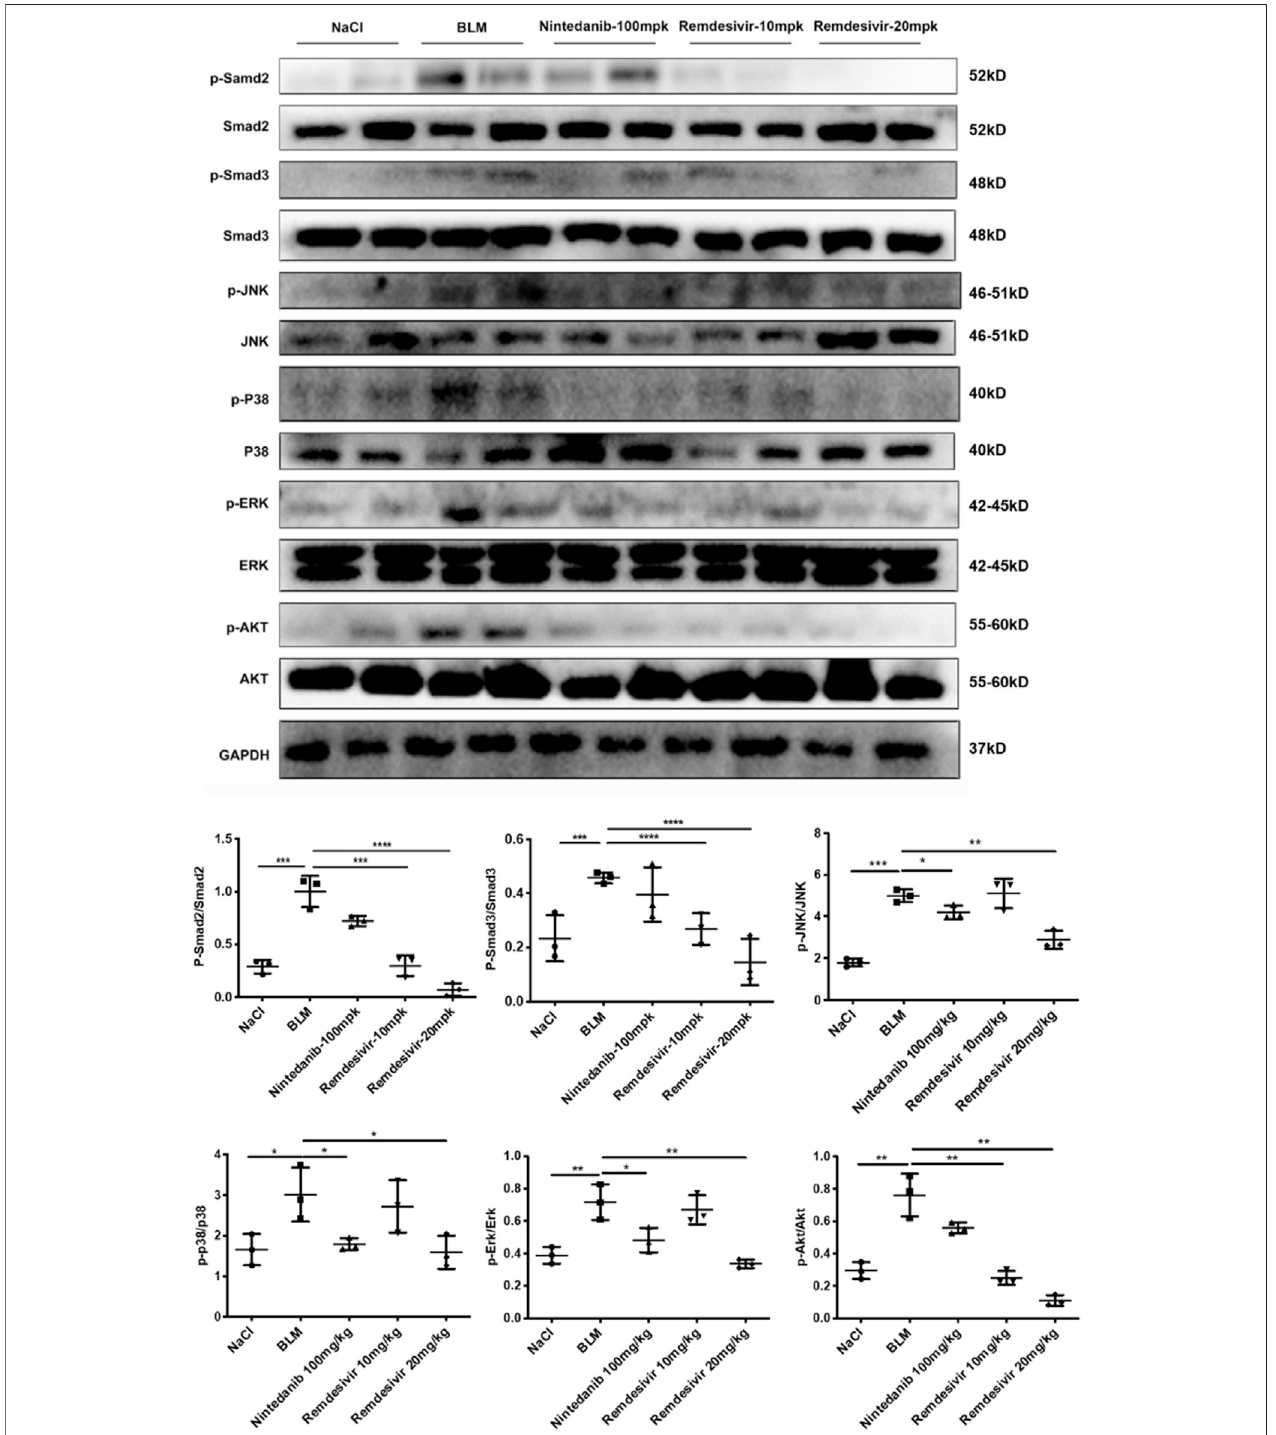
FIGURE 10| Remdesivir suppress BLM-induced pulmonary fi brosis in mice via inhibiting TGF- β 1-Smad and non-Smad signaling pathway in vivo . Protein levels of p-Smad2, Smad2, p-Smad3, Smad3, p-P38, P38, p-JNK, JNK, p-ERK, ERK, p-AKT, and AKT were veri fi ed by Western blot in lung tissues. GAPDH was used as an internal reference in densitometric analysis. Data was presented as the means ± SD, n (cid:1) 3. ** p < 0.01, *** p < 0.001.